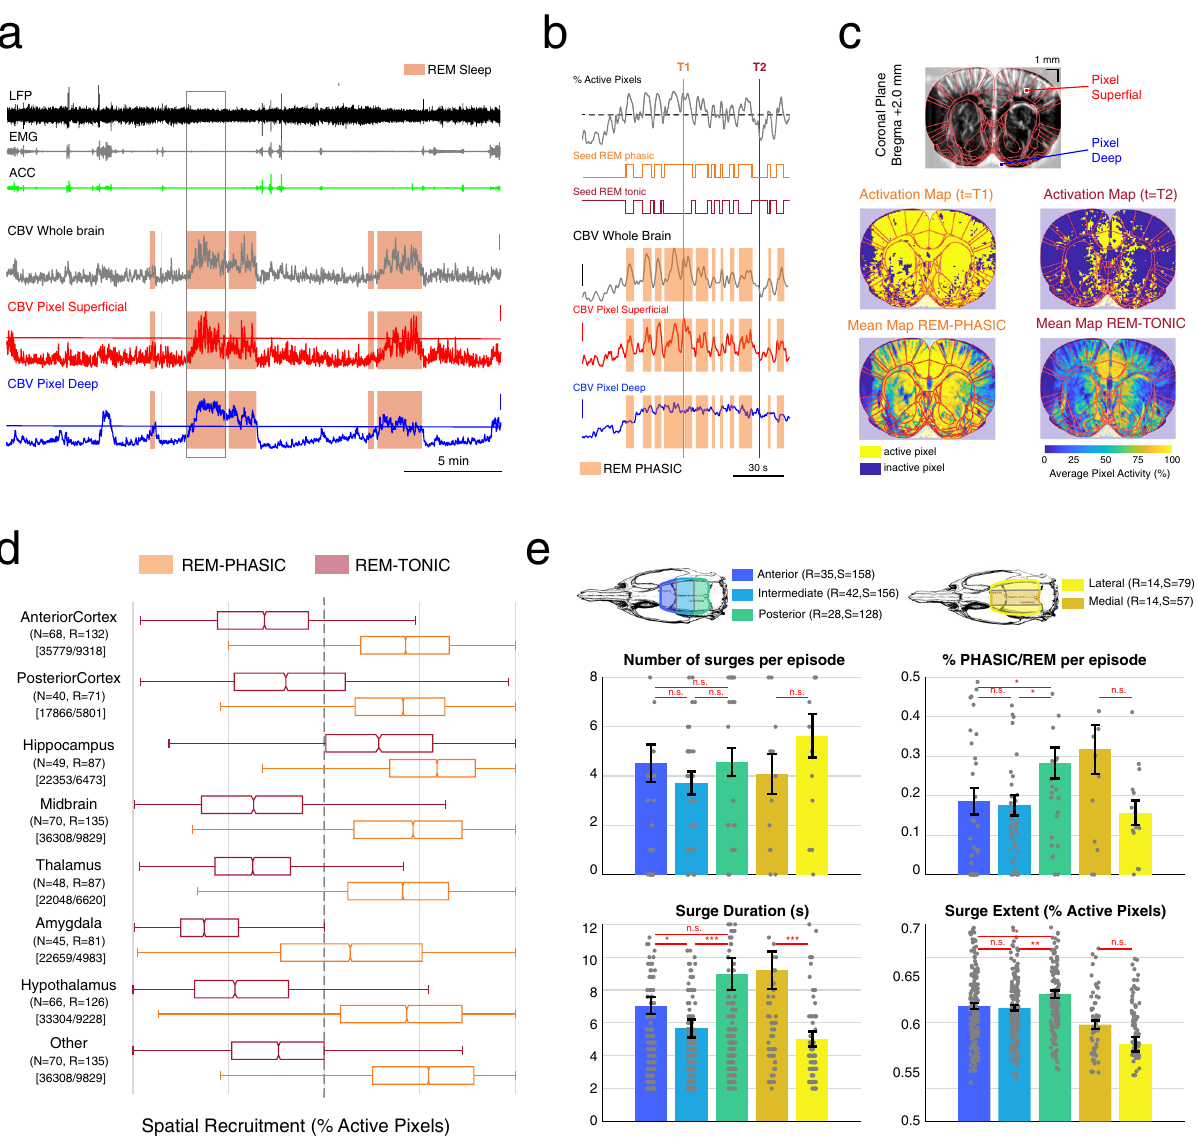
Fig. 2 Spatial distribution and heterogeneities of phasic vascular events across the brain. a (Top to Bottom) Typical time-series for a 30-min recording including raw hippocampal LFP (black), neck EMG (gray), accelerometer (green) and cerebral blood volume (CBV) averaged over the whole brain (gray), in a super fi cial pixel (red) and in a deep pixel (blue). For these two latter time-series, the activation threshold used to detect vascular surges is displayed horizontally (see Methods). Note how super fi cial pixel activity oscillates around the activation threshold whereas the deep pixel ’ s stays well above threshold. Vertical bar 20% Δ CBV. Horizontal bar 5 min. b Details of a single REMS episode, box shown in a . (Top) Time-series of the proportion of active pixels within all brain pixels in the recording plane with 50% threshold (dashed line). REM-phasic epochs are de fi ned as time intervals with >50% of active pixels (orange) whereas REM-tonic epochs are time-intervals with <50% of active pixels (brown). (Bottom) Details of CBV in the whole brain, super fi cial and deep pixels shown in a overlaid with REM-phasic epochs (dark red boxes). c (Top) fUS recording plane (Bregma + 2.0 mm) with Paxinos atlas manually registered and overlaid in red as well as the locations of super fi cial and deep pixels, which activity is shown in (A-B) (Bottom) Instantaneous and mean activation maps computed for REM-phasic (top) and REM-tonic (epochs). Instantaneous activation maps display the proportion of active pixels (yellow) within a single temporal frame (left) and mean activation maps display the above-threshold activity during a single recording. d Box plots showing the distribution of spatial recruitment across 8 major brain regions during REM-phasic and REM-tonic epochs, for all REMS episodes. Note the strong difference between tonic and phasic distributions in the cortical structures, as opposed to non-cortical ones. Box plots show respectively the minimal (left whisker), 25% quartile (left notch), median (middle bar), 75% quartile (right notch) and maximal value (right whisker). e Heterogeneities in vascular surge distributions, durations and extent according to their location in the brain. Coronal recordings were subdivided in 3 groups (anterior, intermediate and posterior) and sagittal recordings in two groups (medial and lateral). REM-phasic events occur as frequently in all fi ve groups but there was a marked increase in the percentage of phasic REM-sleep for posterior and medial groups, as well as longer and more spatial extended vascular events according to other groups. Gray dots show individual values for each REMS episode (top) or vascular surge (bottom). Error bars represent mean + / − standard-error of the mean. Statistical testing was conducted under the null hypothesis ‘ no difference between the mean values observed in the two groups ’ via Wilcoxon signed rank test (n.s. non-signi fi cant: P > 0.05, * P < 0.05, ** P < 0.01, *** P < 0.001). Exact values are provided as a separate fi le. Scale bar from c = 1 mm. Atlas images adapted from The Rat Brain in Stereotaxic Coordinates: Compact, Paxinos G. and Watson C., Copyright (2017), with permission from